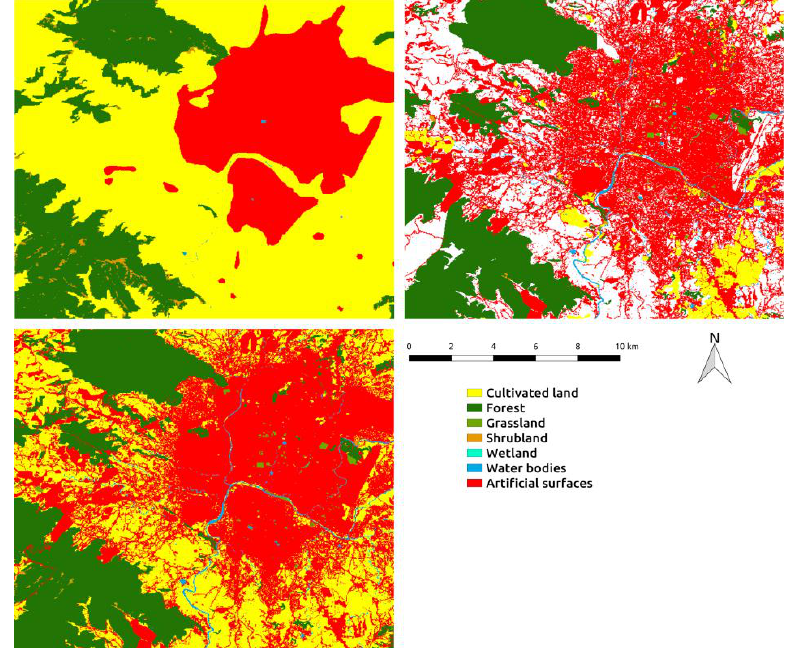
Figure 5. Original GL30 ( upper left ), OSM-derived LULC map ( upper right ) and updated GL30 ( lower left ) for the Kathmandu study area.